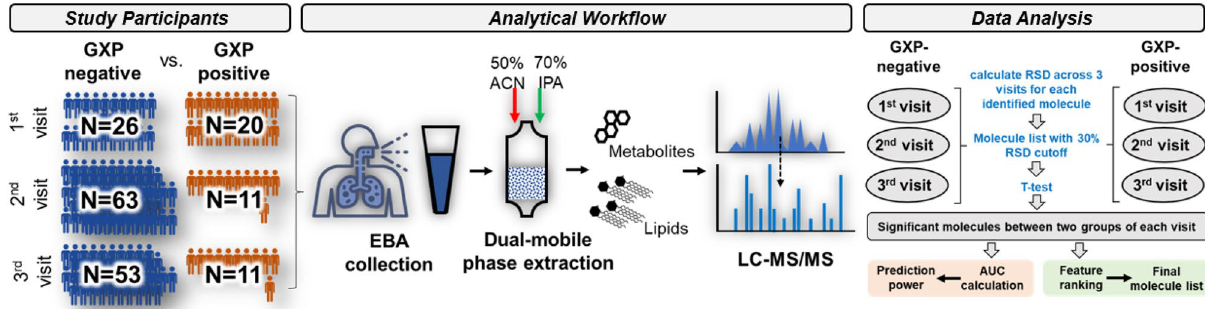
Figure 1. CORTIS participant information and workflow for identification of NOCs from EBA samples. The total number of CORTIS study participants who tested negative (GXP-negative) or positive (GXP-positive) with GeneXpert MTB/RIF are shown. EBA samples were collected as previously described 5 . A dual-mobile phase extraction method, utilizing 50% ACN and then 70% IPA, enabled extraction of small metabolites and lipids from the EBA samples. Extracted molecules were processed with LC–MS/MS and identified via database matching. Relative standard deviation (RSD) of each identified molecule was calculated for each group. Molecules with < 30% RSD were used for t -test between GXP negative and positive of each visit. Molecules showing statistical differences in all visits were used to generate receiver operating characteristic (ROC) curve and area under the curve (AUC) calculation. A feature ranking algorithm was used to show the importance of identified